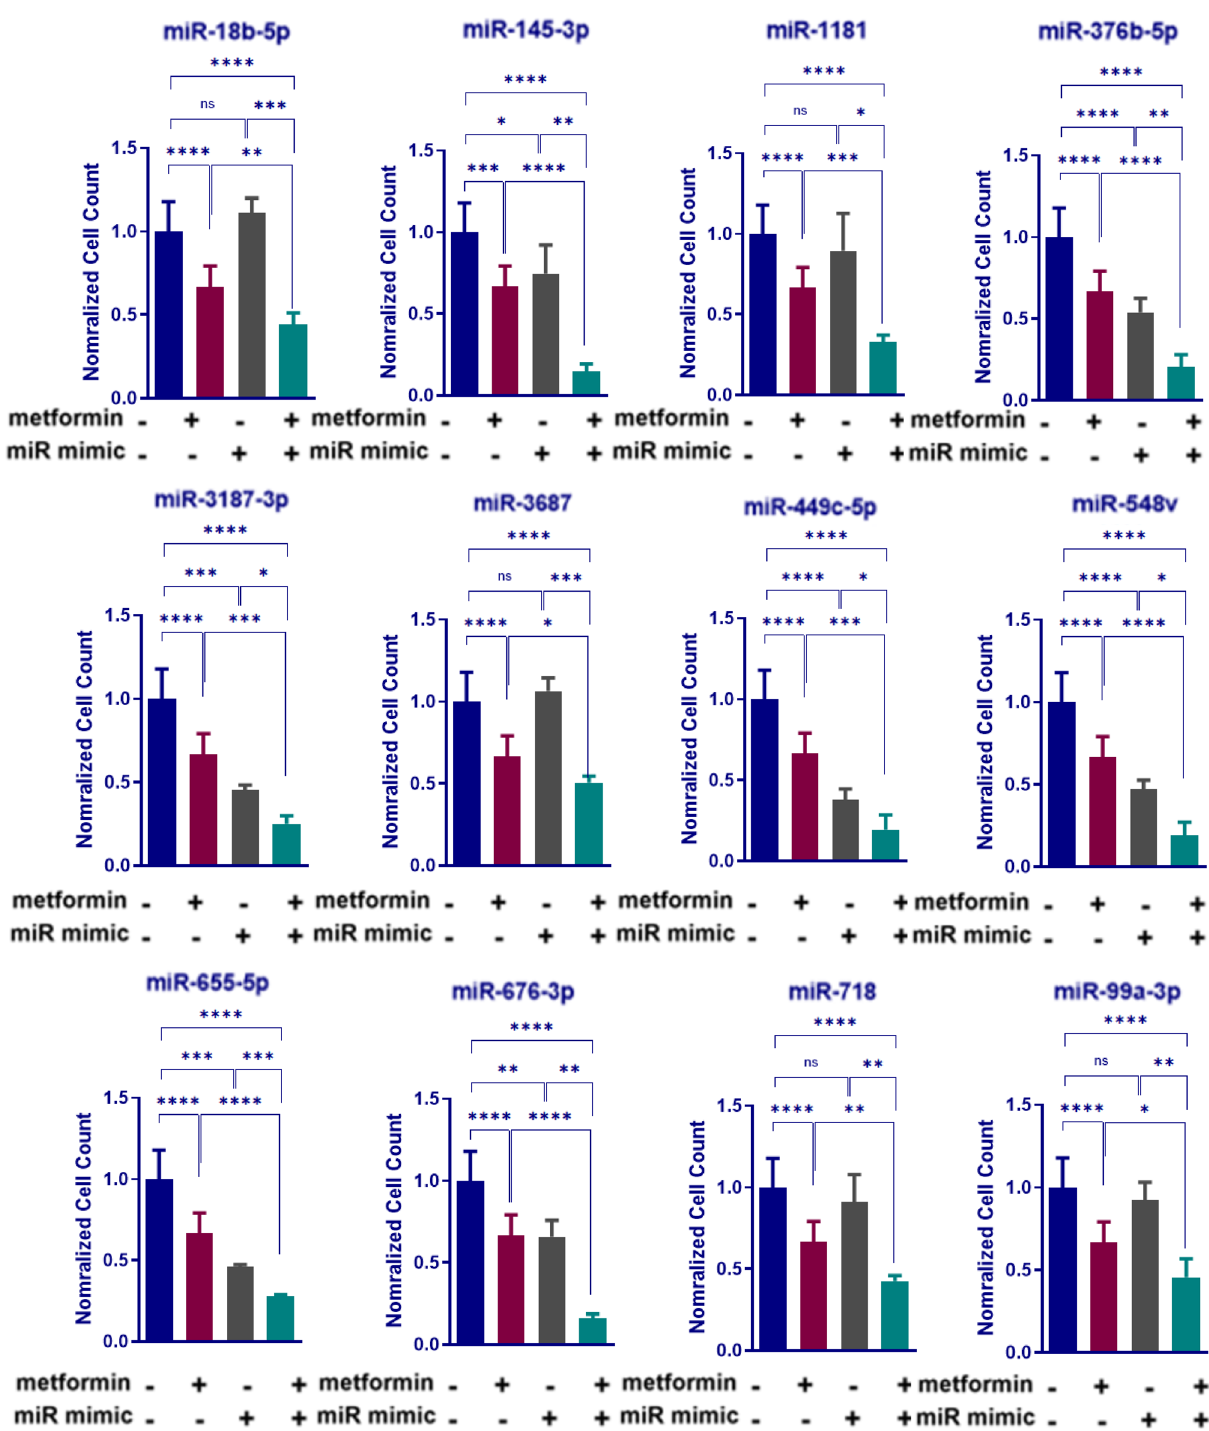
Figure 2. Viability of HCT116 cells transfected with miRNA mimics that show a strong synergetic effect with 2.5 mM metformin treatment. Normalized cell counts of HCT116 cells transfected with miRNA mimics, treated with 2.5 mM metformin and compared with 0 mM metformin treatment. Results are expressed as mean ± SD of 3 replicates and the statistical significance is indicated with asterisks (ns P > 0.05, *P ≤ 0.05, **P ≤ 0.01, ***P ≤ 0.001 and ****P ≤